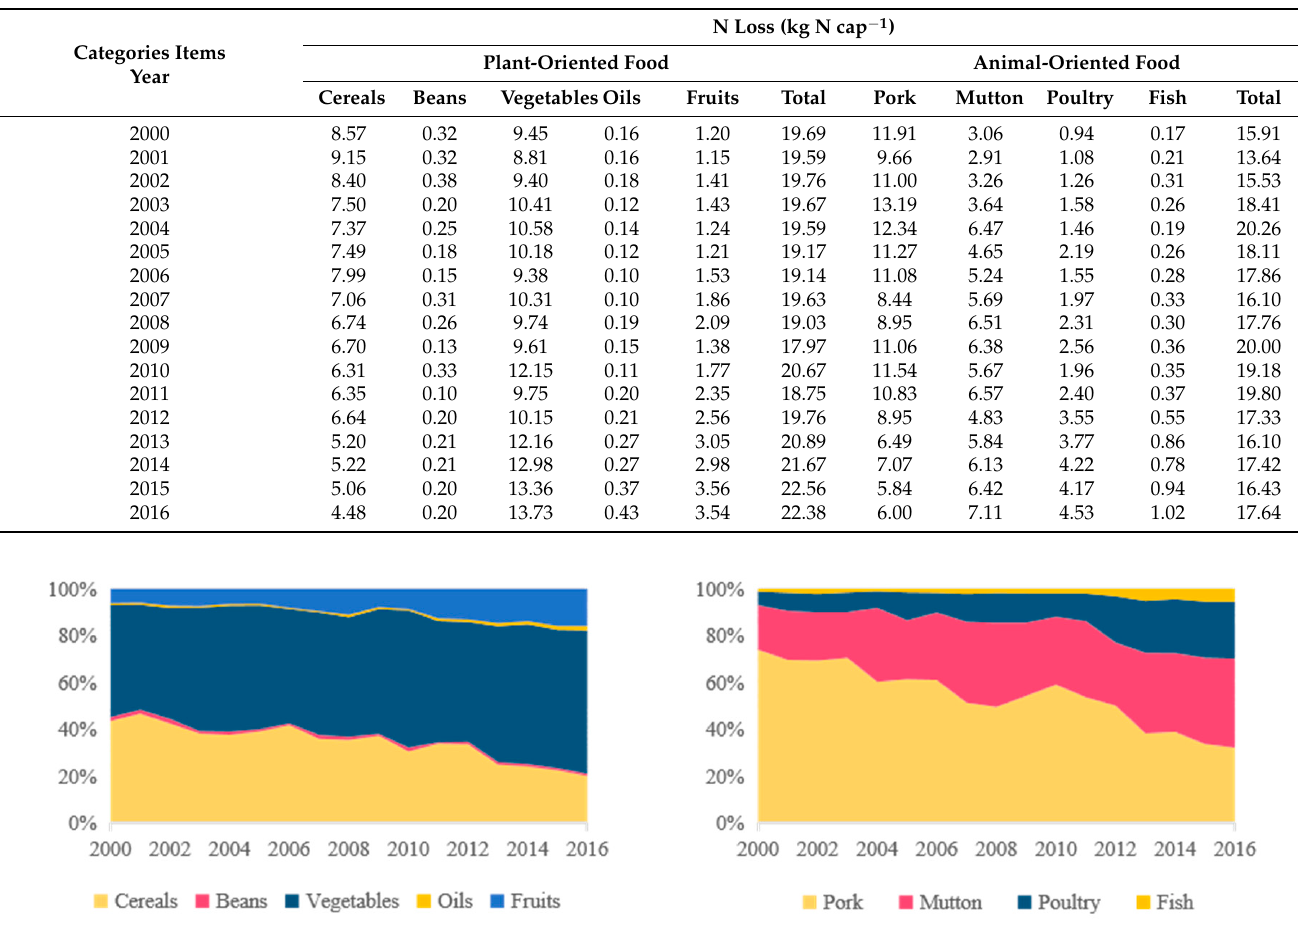
Figure 6. The proportion of N losses from different species among the plant- and animal-oriented food items from 2000 to 2016. Although the contributions of different food items to N losses to air and water did not differ largely among the three regions, there were large differences in the amounts and changes of the N losses (Table 3). Notably, the N losses to the environment in the pastoral region increased sharply by 103.79% from 22.67 to 46.20 kg N cap − 1 over the 16 years studied. The most significant change between the two food categories was for animal- oriented food, for which N losses increased by 142.57% from 11.98 kg N cap − 1 , while the losses from plant-oriented food grew more slowly (10.51%). It is necessary to emphasize that the N losses caused by mutton surprisingly increased by 444.90% from 3.43 kg N cap − 1 because of the dramatic increase in the consumption of mutton by consumers. Compared to the pastoral region, the change in TN losses was smaller in the farming–pastoral (9.45%) and farming (8.44%) regions. In the farming region, N losses increased from 34.24 to 37.13 kg N cap − 1 , while plant-oriented food grew at a higher rate (11.07%) than animal- oriented food (5.00%). The situation was complex in the farming–pastoral region, although the N losses from plant-oriented food decreased by 7.22% from 20.08 kg N cap − 1 , the N losses from animal-oriented food increased excessively (30.52%), which increased the N losses from 15.89 to 20.74 kg N cap − 1